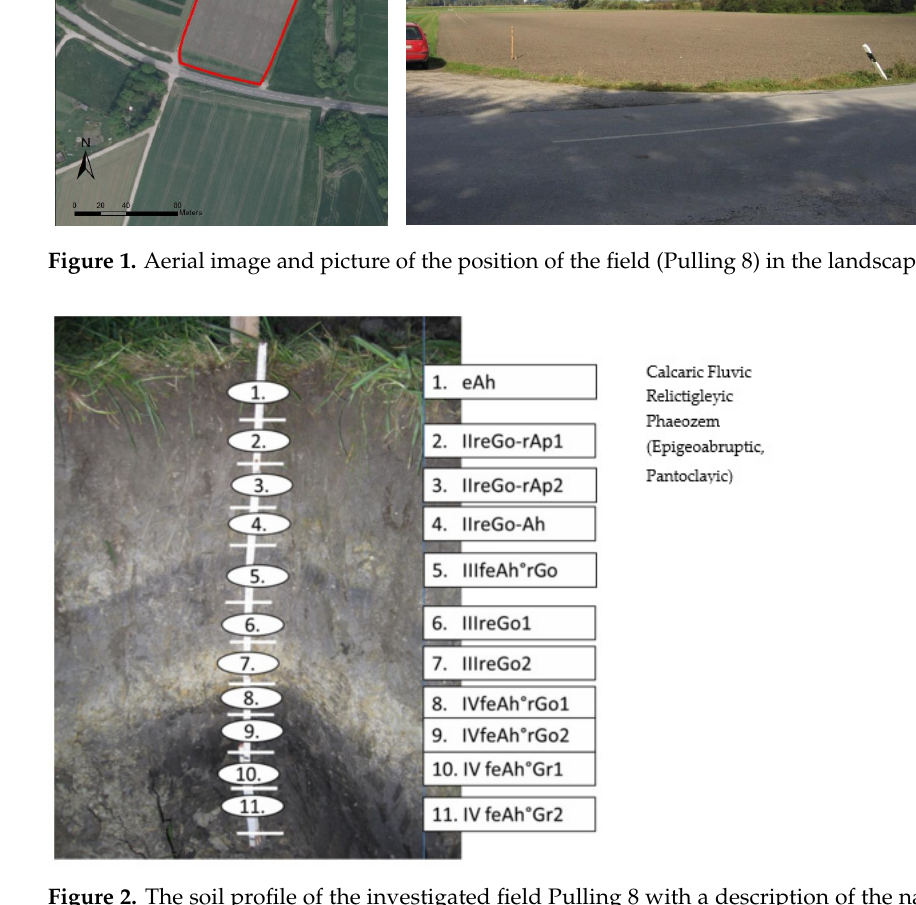
Figure 2. The soil profile of the investigated field Pulling 8 with a description of the names of the horizons and vertical discontinuities (abbreviations from [38]).